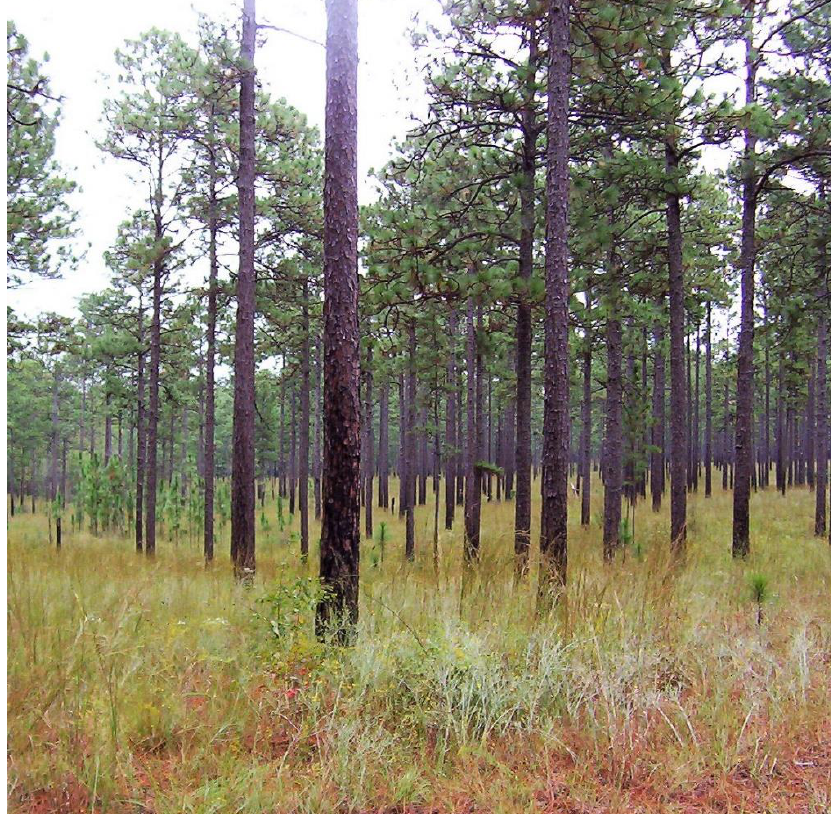
Figure 1. Longleaf pine regeneration in a longleaf pine savannah ecosystem. Note: “bolting seedlings” in the back left. (photograph by Mary Anne Sword, USDA Forest Service).